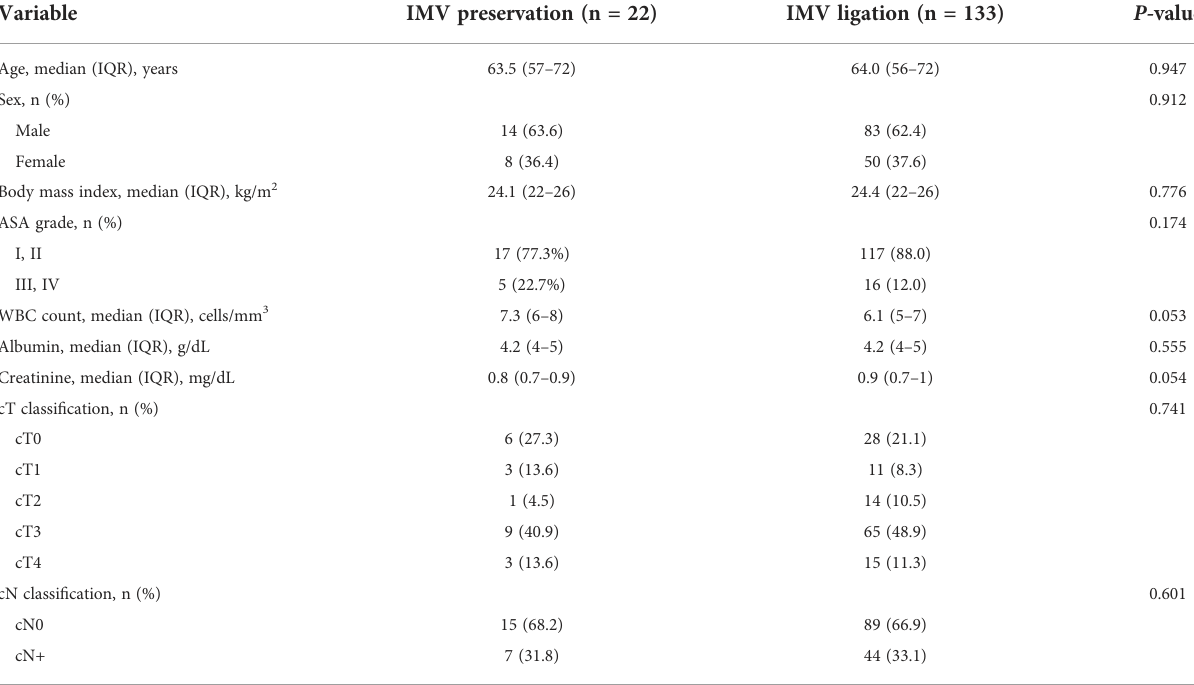
TABLE 1 Patients ’ baseline